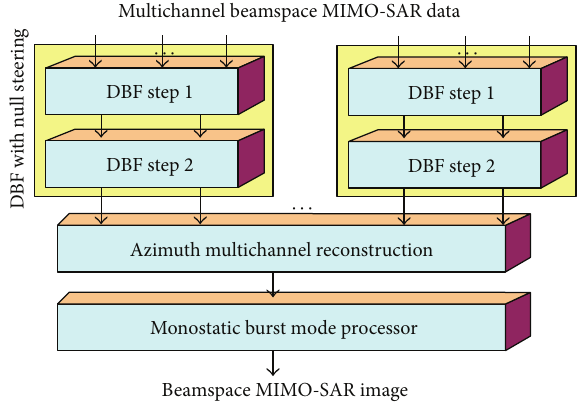
Figure 5: Block diagram of the proposed imaging